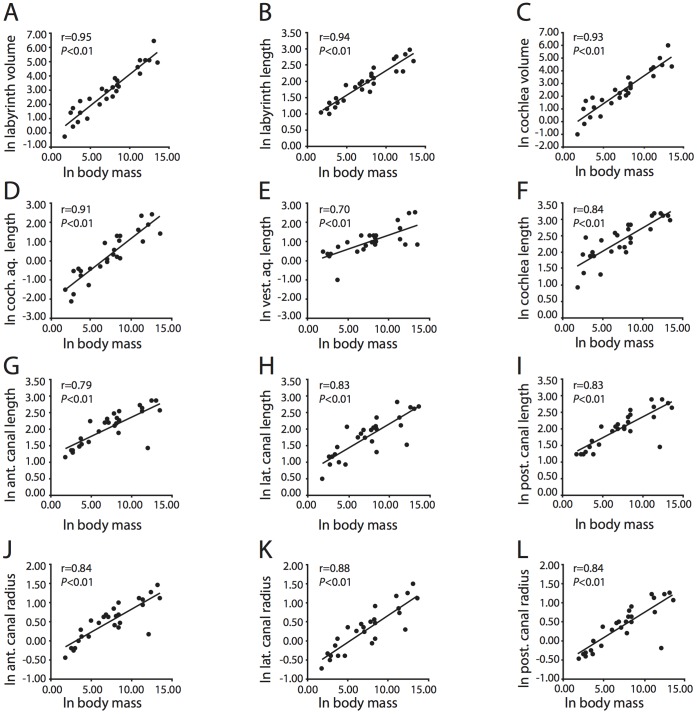
Bivariate plots of labyrinth dimensions over body mass.All data logarithmically transformed using the natural logarithm (ln). A, total labyrinth volume over body mass; B, total length of labyrinth over body mass; C, volume of cochlea over body mass; D, length of canaliculus cochleae for aqueduct of cochlea over body mass; E, length of bony channel for aqueduct of vestibule over body mass; F, length of cochlear canal over body mass; G, length of slender portion of anterior semicircular canal over body mass; H, length of slender portion of lateral semicircular canal over body mass; I, length of slender portion of posterior semicircular canal over body mass; J, arc radius of curvature of anterior semicircular canal over body mass; K, arc radius of curvature of lateral semicircular canal over body mass; L, arc radius of curvature of posterior semicircular canal over body mass. The outlier that falls well below regression line in G-L is Tursiops truncatus.